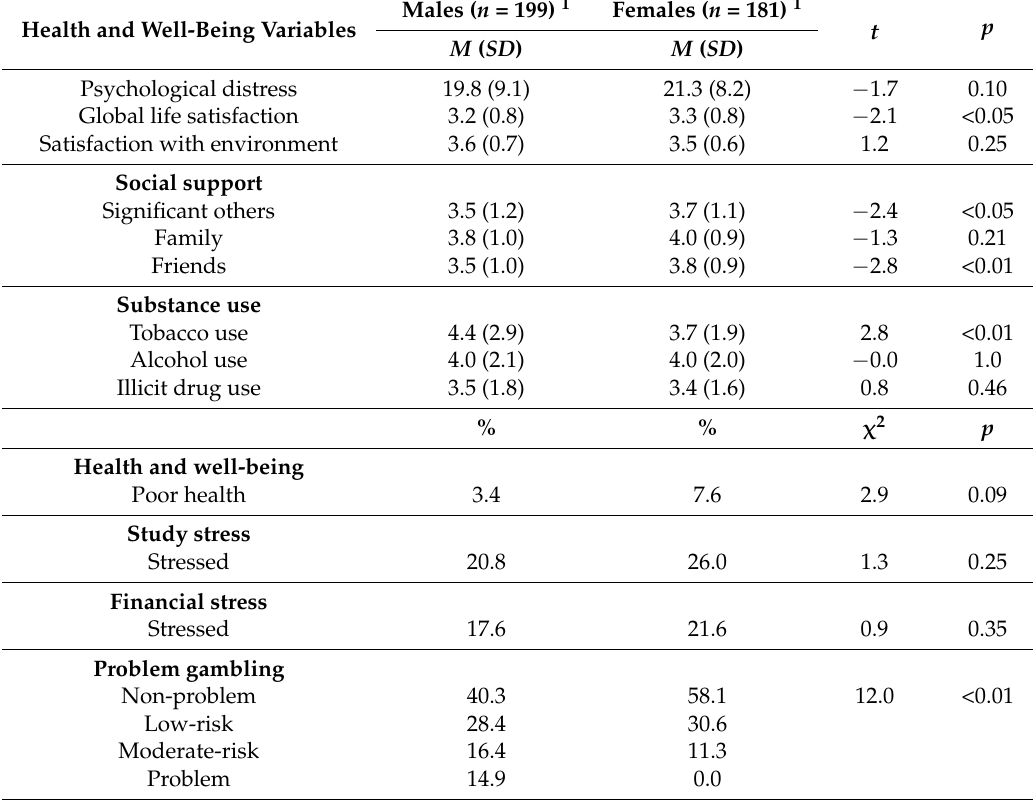
Table 3. Health and well-being among international students by